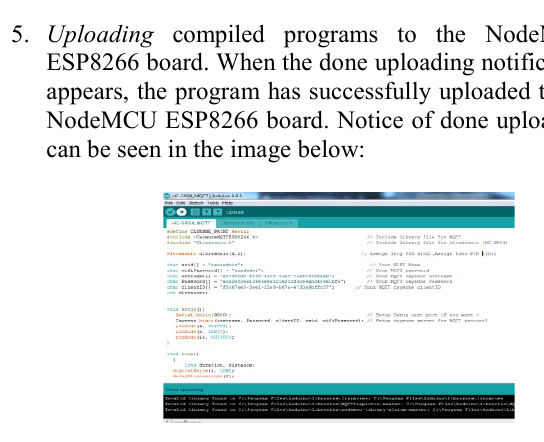
Figure 12. Done Uploading